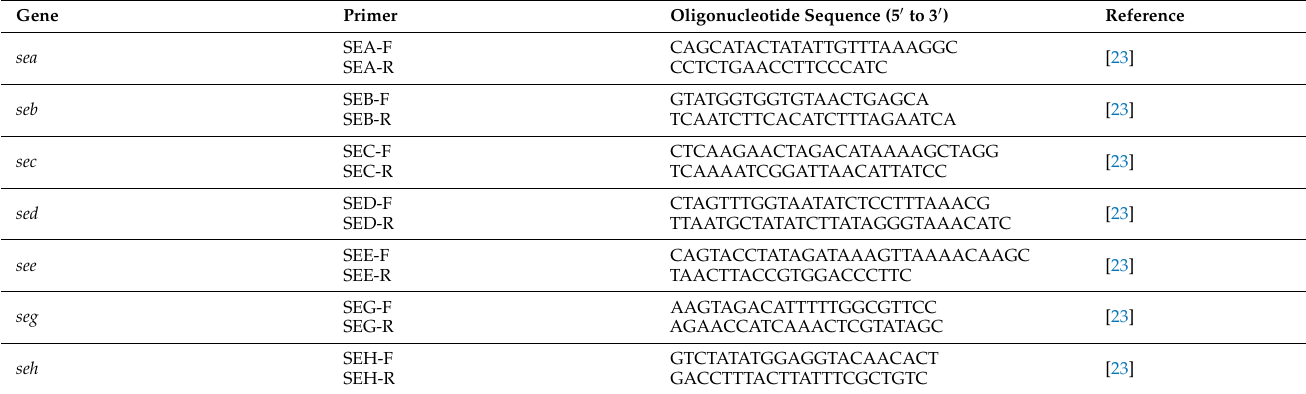
Table 3. Primers used in this